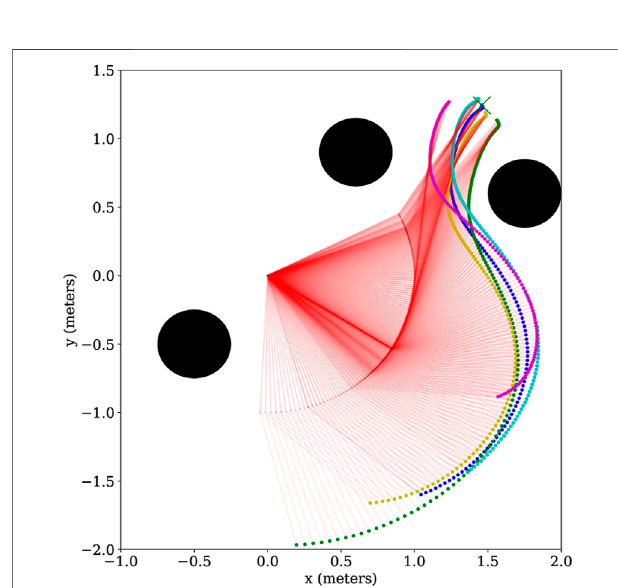
FIGURE 4 | A visualization of the two-link CLF/CBF-based ProMP joint trajectories in the robot workspace. The robot link positions over time are shown in red, while the end-effector trajectory following the mean ProMP joint trajectories is shown in green. The four trajectories of the end effector with joint combinations μ i ± σ i , i ∈ {1,2} are illustrated in cyan, blue, yellow and magenta. The black circles correspond to obstacles. Copyright 2021 IEEE. Reprinted, with permission, from Davoodi et al.,